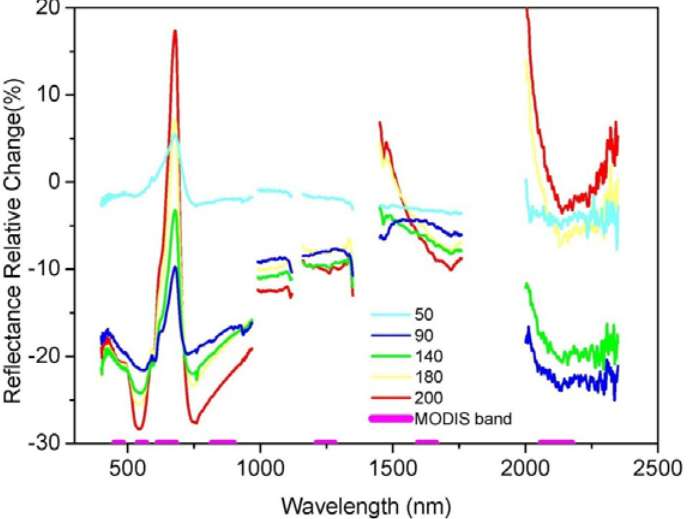
Figure 3. Juniper canopy reflectance changes for various juniper cone densities (50, 90, 140, 180, 200 g/m 2 ) relative to juniper with no cones. MODIS bandwidths and location are shown along the “x” axis.